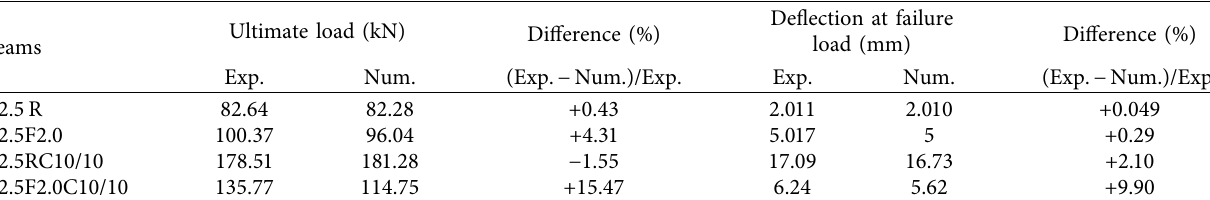
Figure 8: Load-midspan deflection curves obtained from experimental and FEA approach. (a) A2.5 R. (b) A2.5F2.0. (c) A2.5RC10/10. (d) A2.5F 2.0C10/10. Table 6: Numerical model